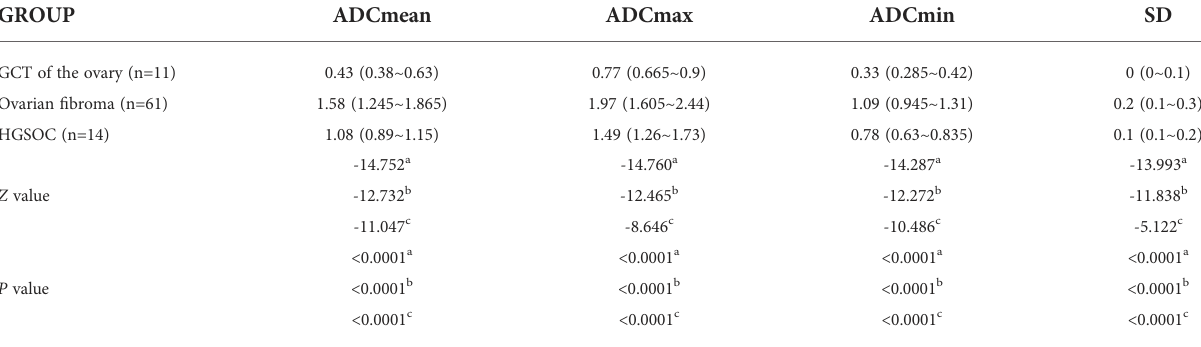
TABLE 3 ADC histogram parameters of three ovarian solid tumors. GROUP ADCmean